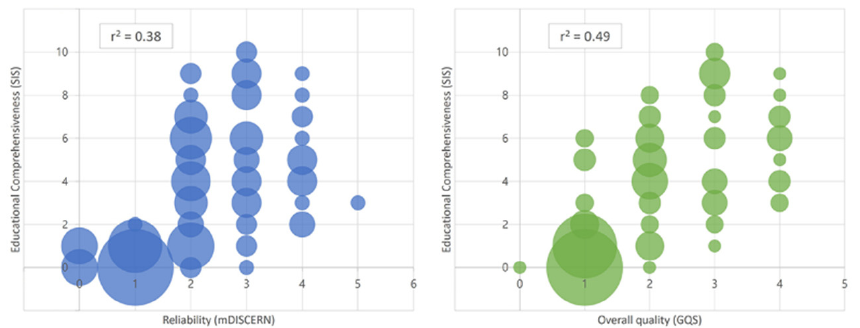
Figure 3. Relationship between the modified DISCERN, global quality score, and shoulder injection score.